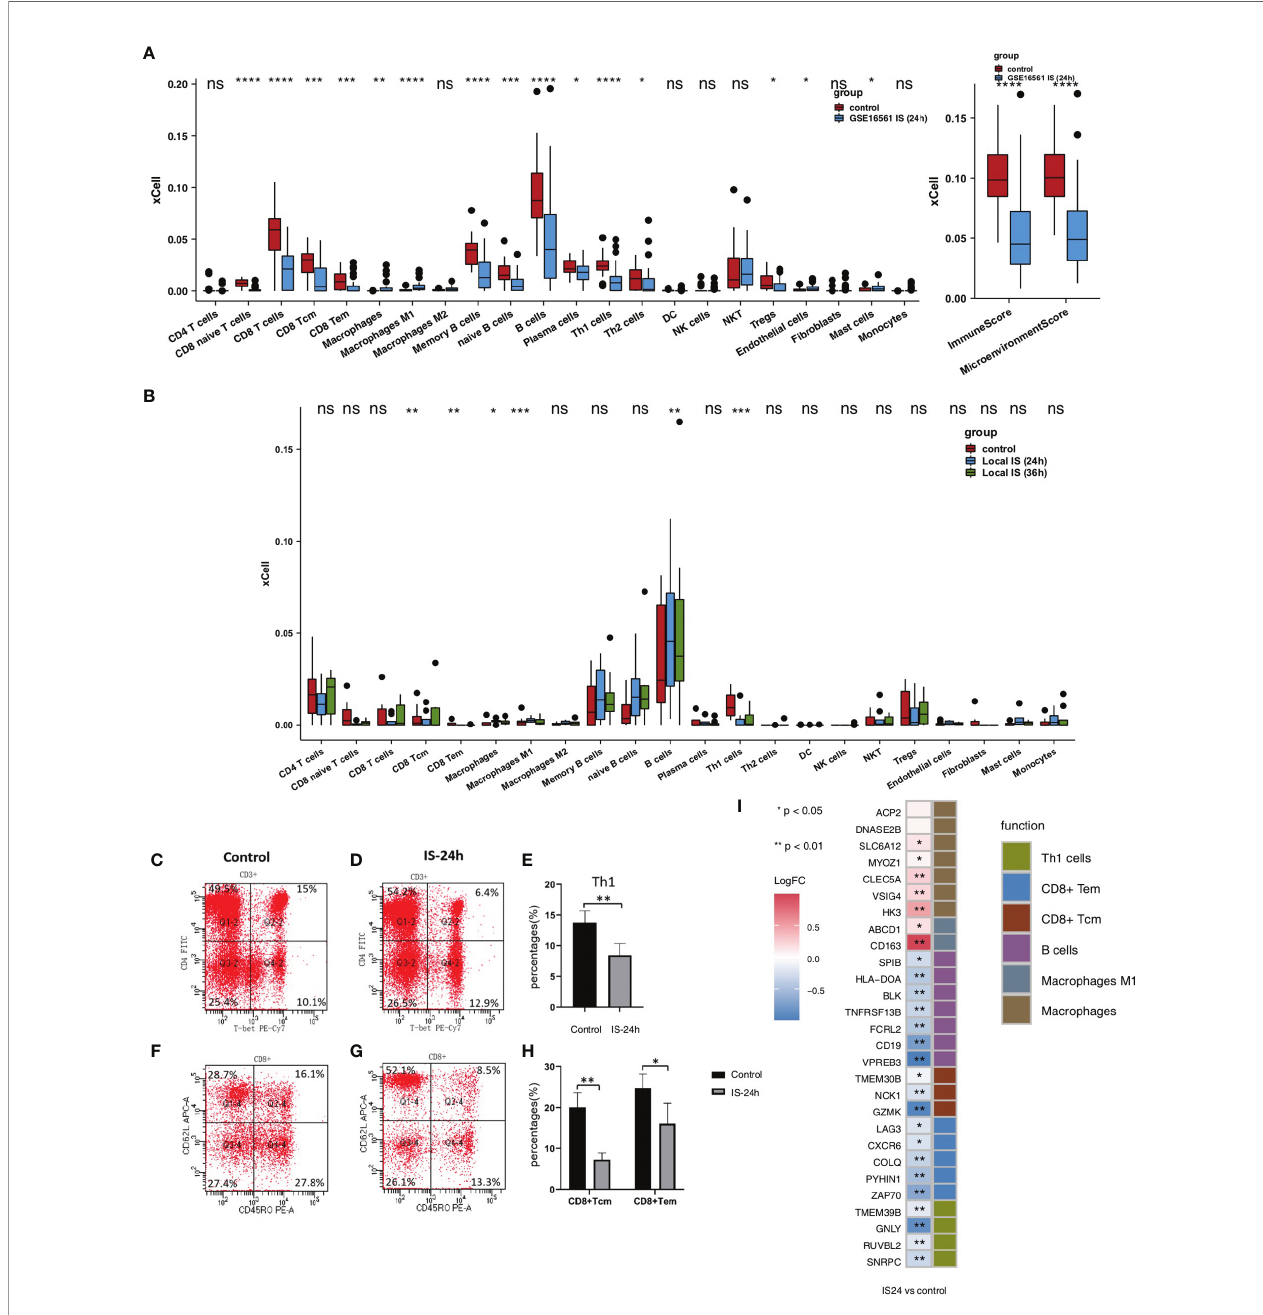
FIGURE 2 | Comparison of the immune cells and cell markers between IS and control group. (A) Comparison of the scores for immune cells estimated by the xCell algorithm between the IS-24h and control groups in GSE16561. (B) Comparison of the scores for immune cells estimated by the xCell algorithm between the IS- 36h, IS-24h and control groups in Local-IS. (C) FACS analysis of Th1 cells in the control group of Local-IS. (D) FACS analysis of Th1 cells in the IS-24h of Local-IS. (E) Percentage of Th1 cells in control and IS-24h. (F) FACS analysis of CD8+Tcm and CD8+Tem in the control group of Local-IS. (G) FACS analysis of CD8+Tcm and CD8+Tem in the IS-24h of Local-IS. (H) Percentage of CD8+Tcm and CD8+Tem in control and IS-24h. (I) Comparisons of the cell markers for CD8+ Tcms, CD8+ Tems, B cells, Th1 cells, macrophages and M1 macrophages between the IS-24h and control groups in GSE16561. (*P < 0.05, **P < 0.01, ***P < 0.001, and ****P < 0.0001; Mann-Whitney U test). ns, not signi fi